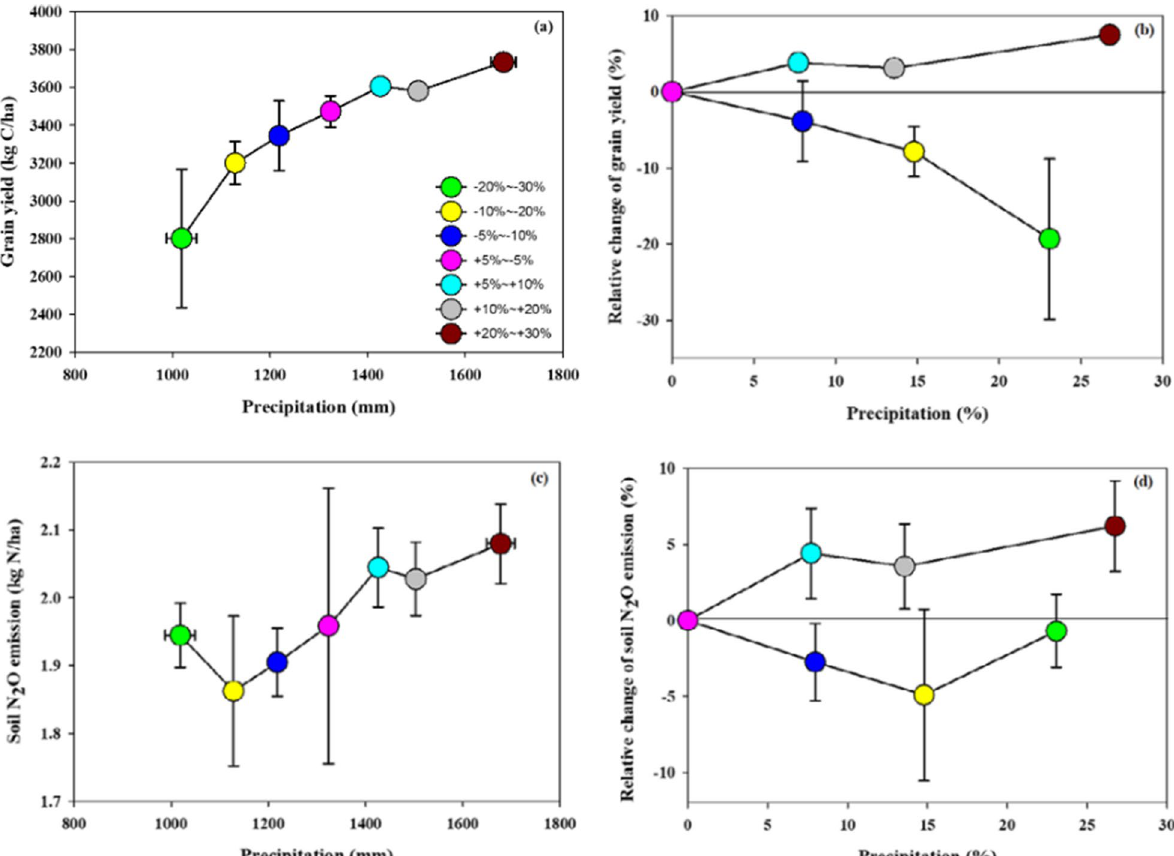
Fig. 3 The responses of corn yield ( a , b ) and soil N 2 O emission ( c , d ) to precipitation change based on the long-term (40 years, 1981–2020) precipitation dataset. Color symbols indicated different precipitation